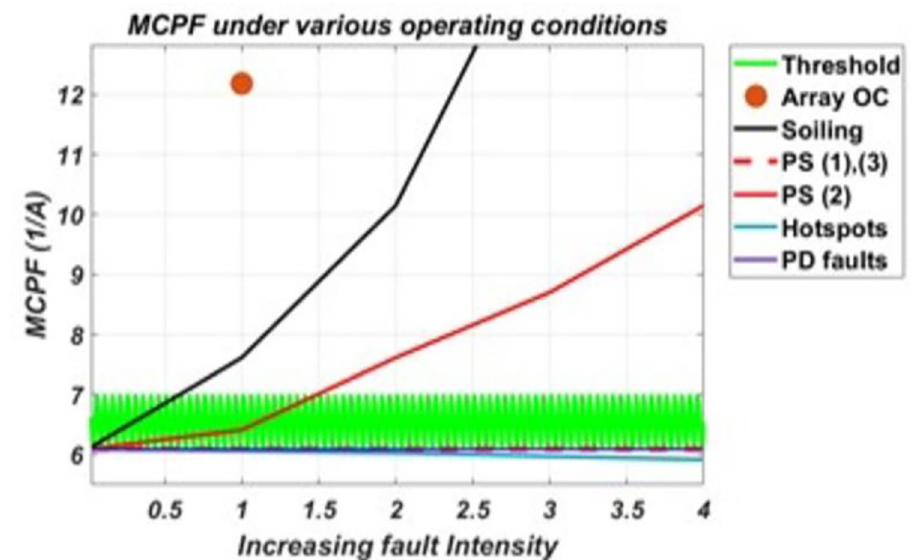
Fig 7. The response of MCPF to various conditions and their varying intensity levels.